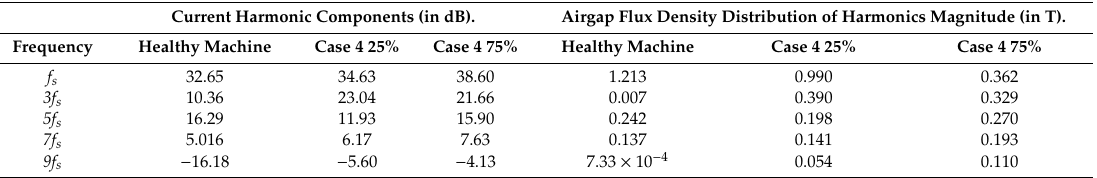
Table 4. Current harmonic components comparison and airgap flux density distribution of harmonics magnitude variations due to case 4.